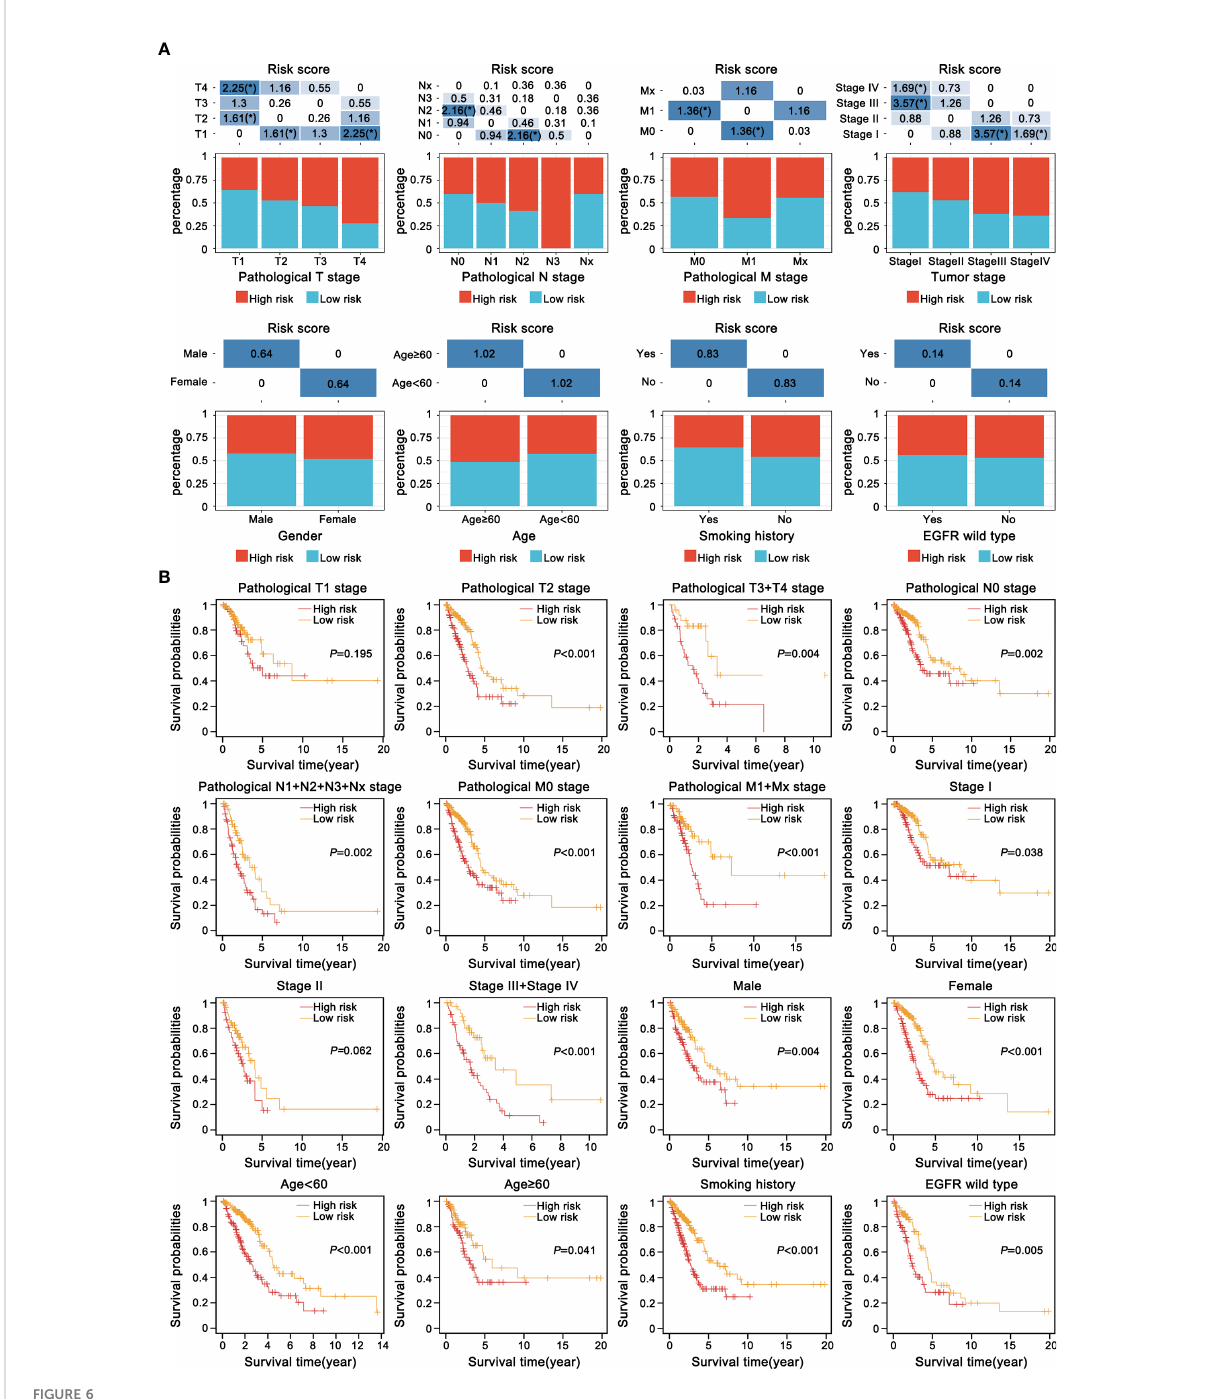
FIGURE 6 Correlation between the current prognostic E-signature and clinicopathologic attributes. (A) The distribution of samples with different risk scores classi fi ed by clinicopathologic traits, including T stage, N stage, M stage, tumour stage, gender, age, smoking history and EGFR mutation. *P < 0.05. (B) KM analysis of each subgroup was strati fi ed by the E-signature to visualize the prognostic value of clinical parameters classi fi